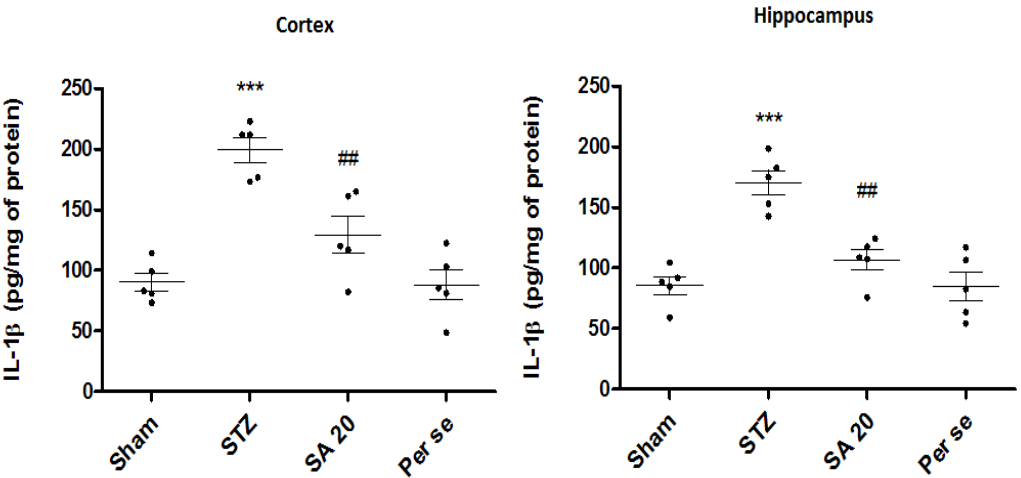
Figure 8. Effect of sinapic acid on IL-1β levels in the cortex and hippocampus. Data are presented as mean ± SEM, ( n = 5). * as compared to the sham group, # as compared to the STZ group. *** p < 0.001, ## p < 0.01. STZ—Streptozotocin, SA—Sinapic acid.